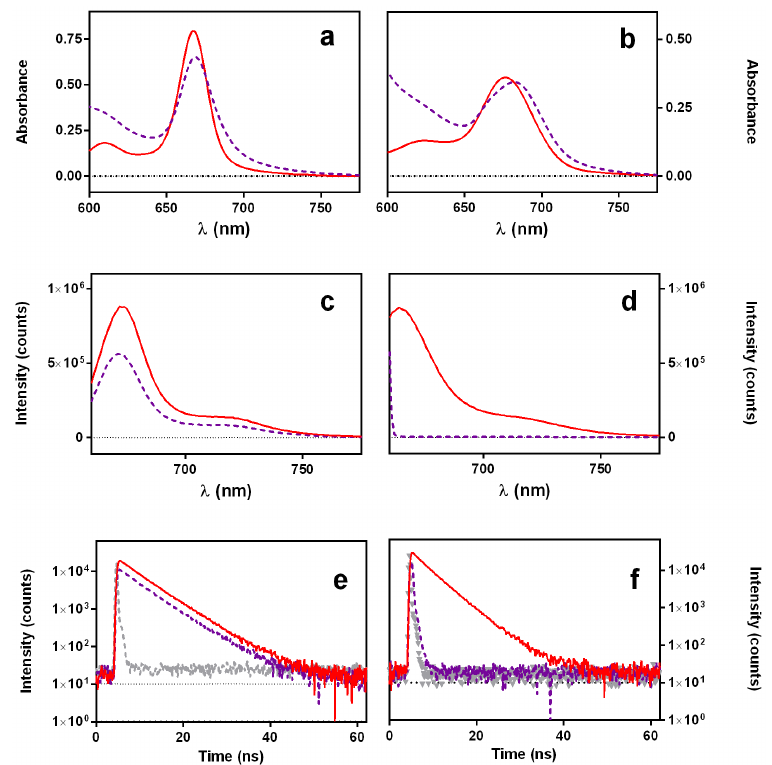
Figure 4. Absorption spectra ( a , b ), fluorescence spectra ( c , d ) and fluorescence decay ( e , f ) of PhA 25 μ M alone (red solid lines) and in the presence of 1 mM DOXO (dashed violet lines) in EtOH (left panels) and H 2 O (right panels) solutions. For TRF measurements, λ exc = 654 nm and λ obs = 750 nm. Grey dashed traces correspond to the instrument response function.